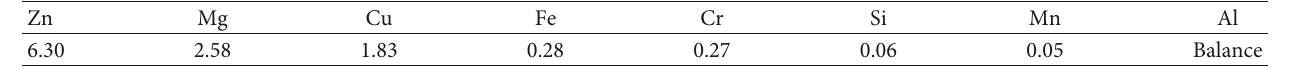
Table 1: Elemental proportion of AA7050 aluminium alloy.